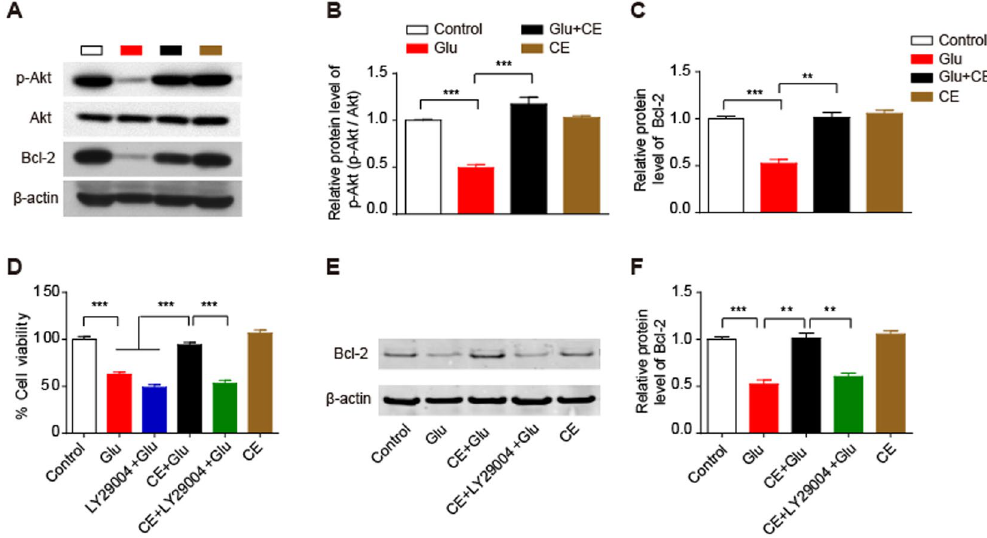
Figure 4. Involvement of the PI3K/Akt pathway in the neuroprotective effect of CE. ( A , B and C ) Cell lysates were analysed by immunoblotting to measure the relative levels of proteins involved in the Akt signalling pathway, including phosphorylated (Ser473) Akt and its downstream target Bcl-2 ( A ). Quantification of p-Akt and Bcl-2 protein levels is shown in ( B and C ), respectively. ( D ) Cell viability was measured using the MTT assay. In this experiment, cells were pretreated with the Akt inhibitor LY29004 for 30 min prior to treatment with CE or glutamate. ( E and F ) Immunoblot showing the Bcl-2 protein level ( E ); the intensity of the bands in each lane was quantified ( F ). ( B,C and F ), n = 3; D, n = 5; data are shown as mean ± SEM; One-way ANOVA followed by Tukey’s multiple comparisons test. ** p < 0.01, *** p <